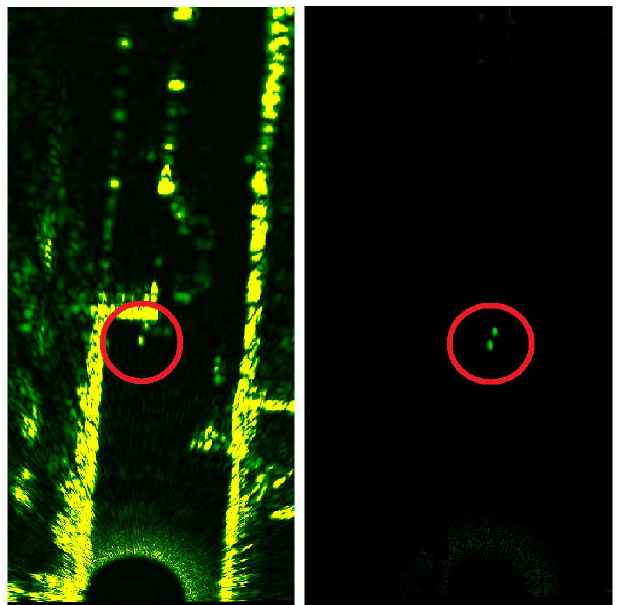
Fig. 3. Locating a small UAV in conditions of intense reflections from surrounding urban objects (buildings). On the left is the primary radar image, on the right is the radar image after application of the MTD procedure